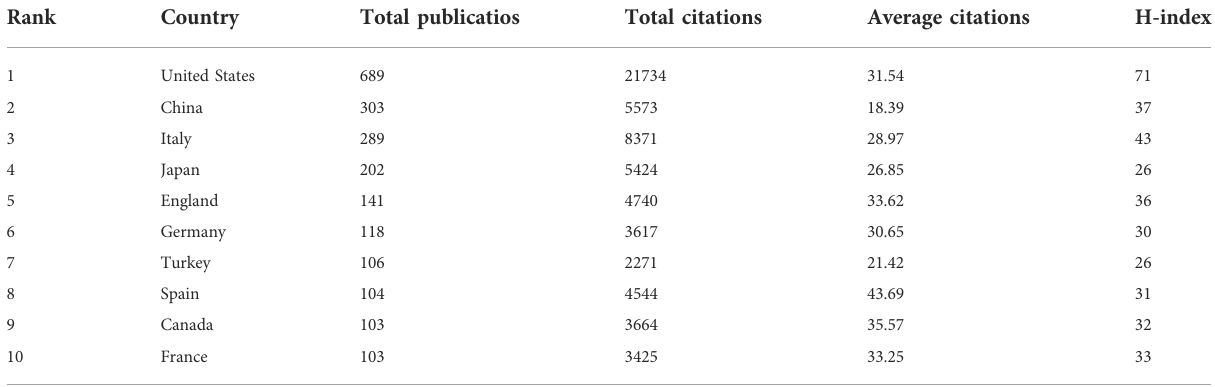
TABLE 1 The top ten countries that contributed publications on HA for the treatment of osteoarthritis.